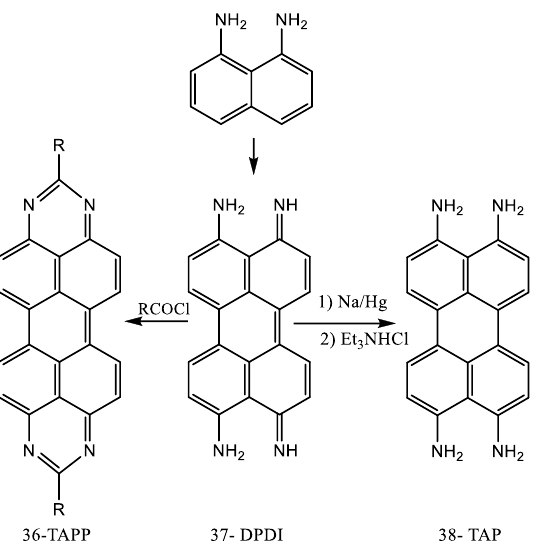
Figure 9. TPBP ( 34 ) (triphenylboranepyridine) and TPBOA ( 35 ) (triphenylboraneoctadecyl). Molecules 2022 , 27 , x FOR PEER